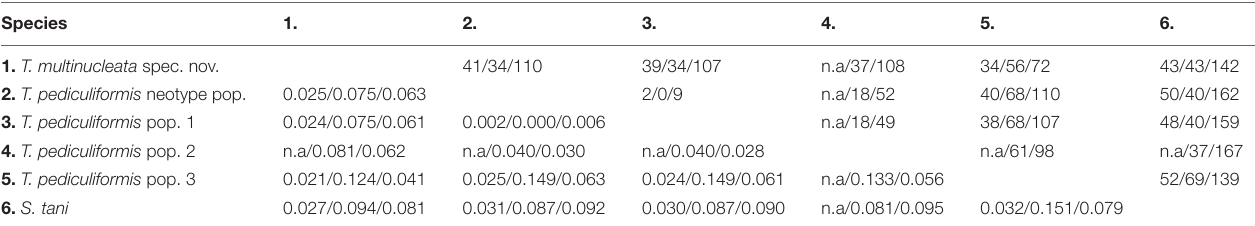
TABLE 4 | Numbers of unmatched nucleotides (above diagonal) and pairwise p- distances (below diagonal) of SSU/ITS1-5.8S-ITS2/LSU rDNA sequences among members of the family Trachelostylidae. Species 1.